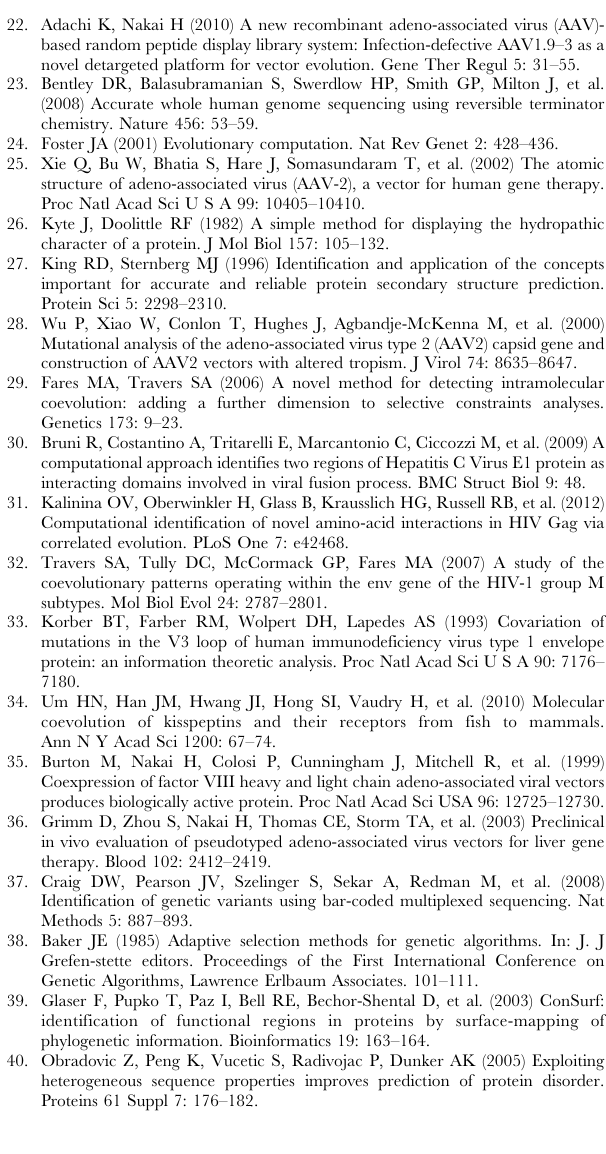
Table S4 AAV and helper plasmids used for AAV production. Table S5 Sample DNA barcode-indexed PCR primers for Illumina sequencing. Table S6 Means and standard deviations of MW, IP and GRAVY scores of the viable VP and AAP heptapeptides.